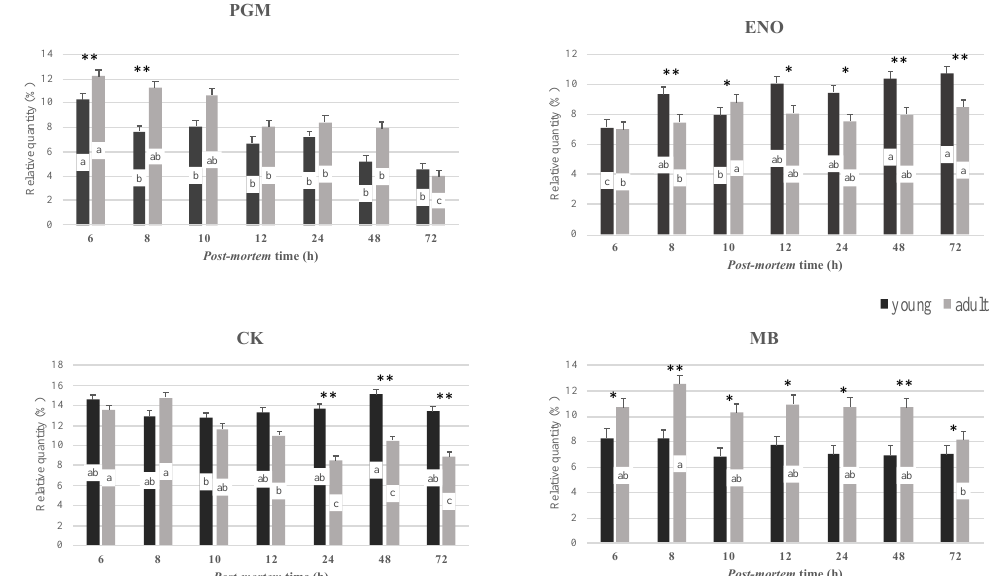
Figure 2. Percentages (%) of the main sarcoplasmic proteins from the longissimus lumborum muscles of young and adult dromedaries after 6, 8, 10, 12, 24, 48 and 72 h postmortem (PGM = phosphoglucomutase; ENO = enolase; CK = creatine kinase; MB = myoglobin; ∗ = p < 0.05; ∗∗ = p < 0.01 slaughter age effect; a–c = p < 0.05 postmortem time effect; and means ± SEM). Postmortem time affected the relative intensity of the sarcoplasmic proteins, mainly phosphoglucomutase ( p < 0.01), enolase ( p < 0.01) and creatine kinase ( p < 0.01), both in adult and young dromedaries. Phosphoglucomutase (PGM) showed a decrease in inten- sity after 8 h postmortem in young dromedaries, while in adult dromedaries a decrease was found starting from 12 h postmortem. Phosphoglucomutase is an enzyme of the gly-